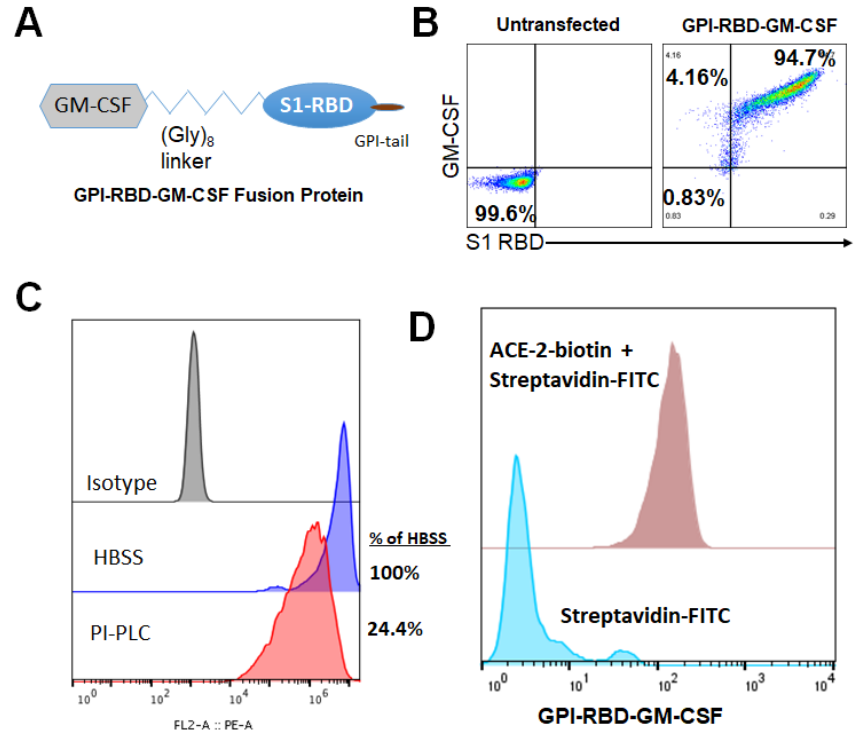
Figure 1. Design, expression and characterization of GPI-RBD-GM-CSF fusion protein. ( A ) Design of GPI-RBD-GM-CSF fusion protein gene, ( B ) GPI-RBD-GM-CSF fusion protein binds both anti- RBD mAb and anti-GM-CSF mAb on CHO-S cell transfectants, ( C ) PIPLC treatment of CHO-S cells expressing GPI-RBD-GM-CSF reduced the level of expression and ( D ) flow cytometry analysis showed binding of human ACE2 to GPI-RBD-GM-CSF fusion protein expressed in CHO-S cells.